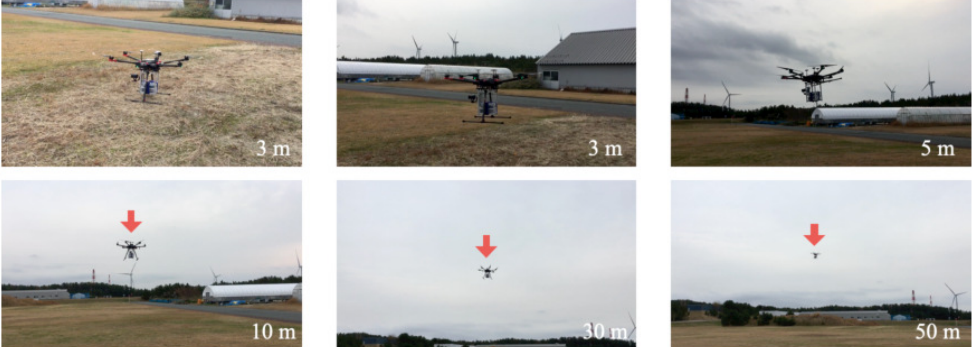
Figure 20. Photograph of D2 flight experiment. The numbers in the lower right corner of respective photographs indicate the approximate distances between the photographer and the drone.